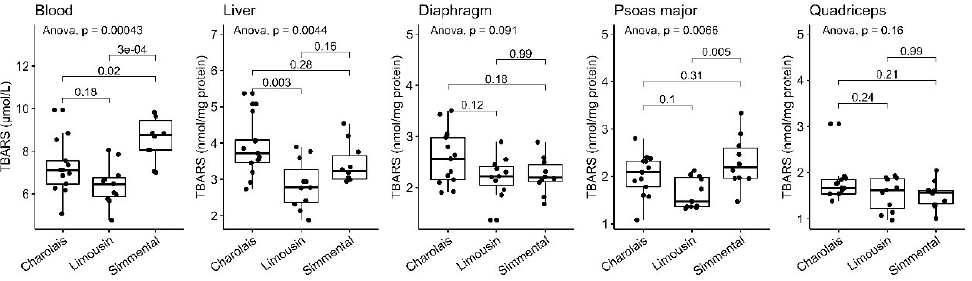
Figure 4. TBARS levels in the blood, liver, diaphragm, quadriceps and psoas major of CHA, LIM and SIM cattle.